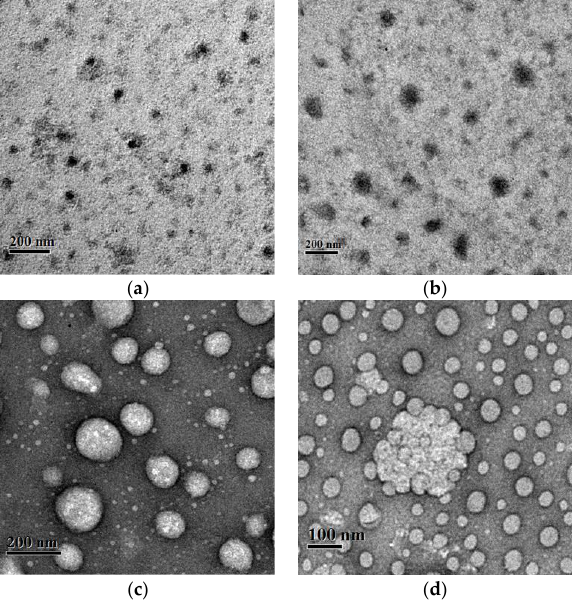
Figure 2. TEM images of polyion complex micelles formed by TCPP and PMVP 41 - b -PEO 205 at the charge ratios of ( a ) 1:1; ( b ) 1:2; ( c ) 1:5 and ( d ) 1:8.